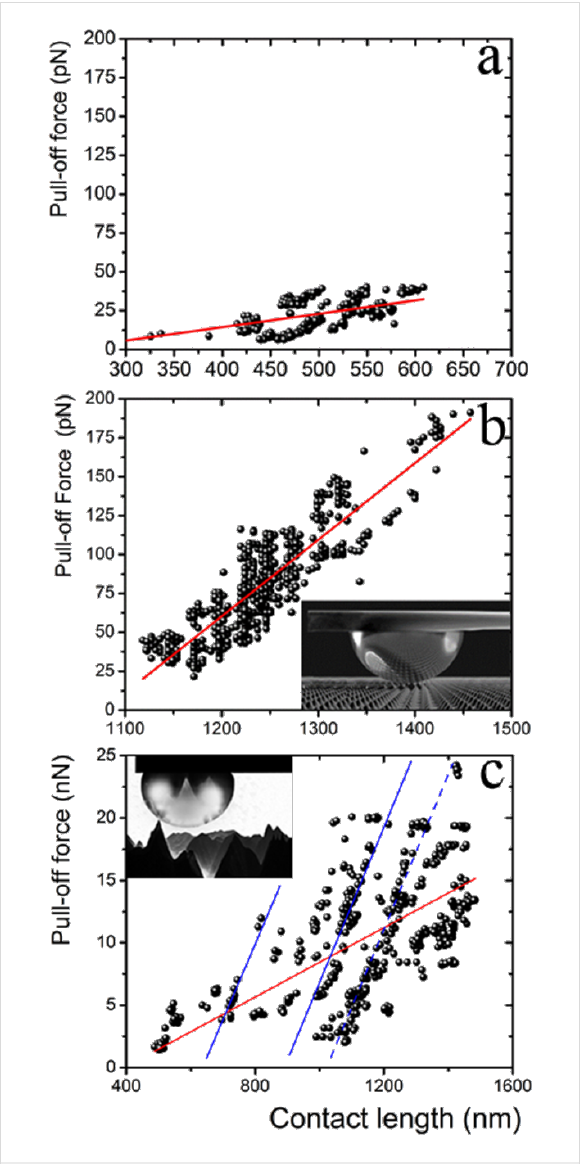
Figure 9: Adhesion force vs contact length between the array of sharp silicon peaks and (a) a hollow glass sphere and (b) a mercury drop; and (c) between the multi-scaled rough diamond surface and a mercury drop. Measurements are performed on different areas of the studied surfaces. The red line corresponds to a linear fit. Inset in (b): Sketch of a mercury drop attached to a tipless cantilever in contact with the array of sharp silicon peaks. Inset in (c): Sketch of a mercury drop attached to a tipless cantilever in contact with the sub-microme- ter protrusions of the multi-scaled rough diamond